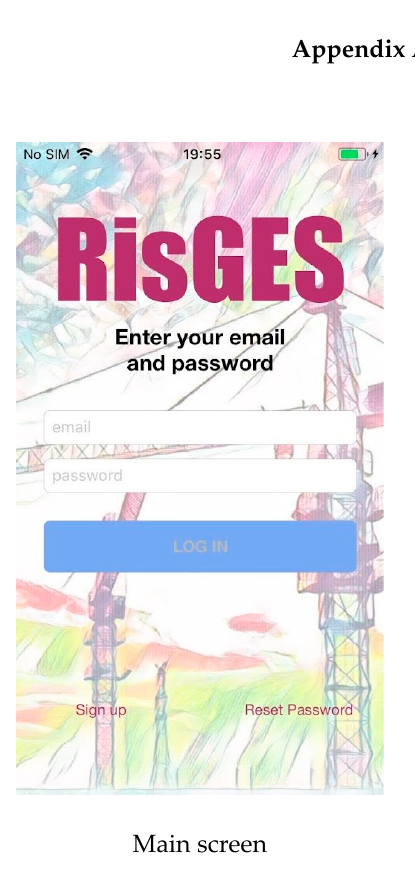
Figure A1. General operation of the application RisGES. Source: App screenshots.